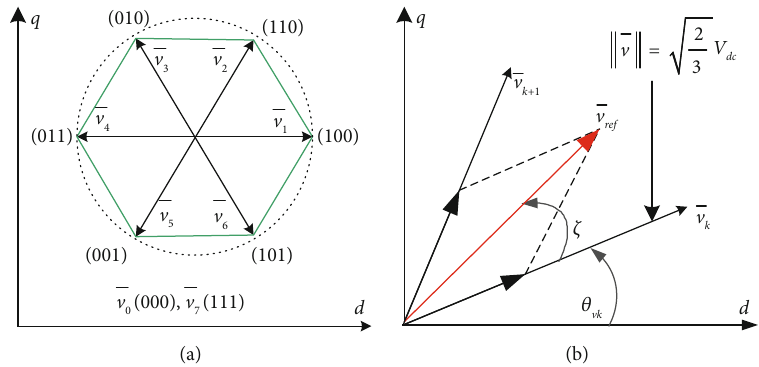
Figure 6: Principle of the SVPWM technique: (a) the voltage space vectors of the three-phase inverter; (b) synthesis of the